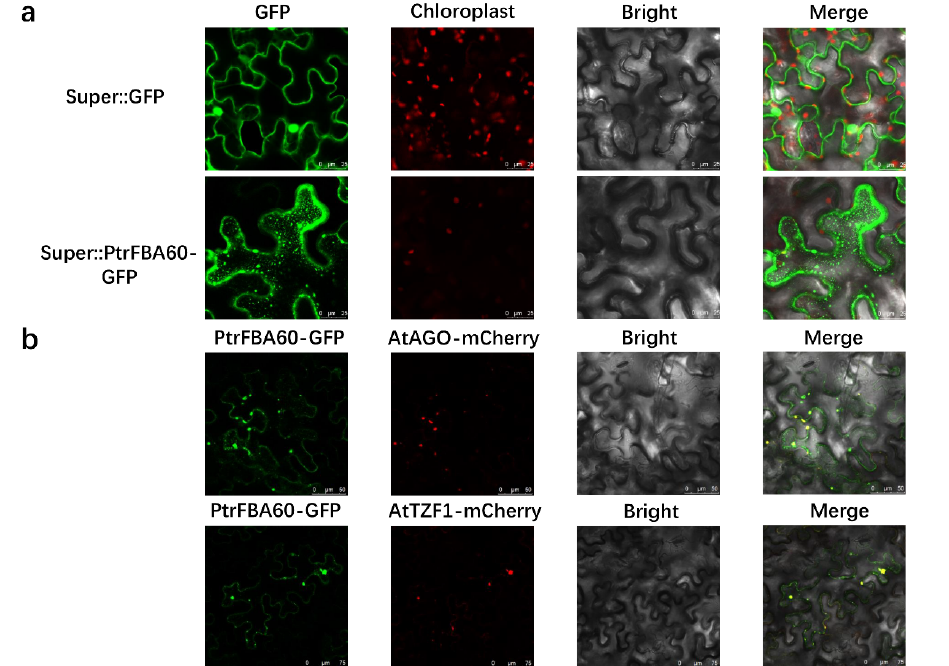
Figure 10. The location of PtrFBA60 in P-Bodies of tobacco. ( a ) The Super::GFP and Super:: PtrFBA60 -GFP fusion proteins were transiently expressed in tobacco. ( b ) PtrFBA60 -GFP and AtAGO-mCherry, AtTZF1-mCherry co-location in tobacco and PtrFBA60 colocalized with PB (P-body) markers AtAGO1 and AtTZF1.